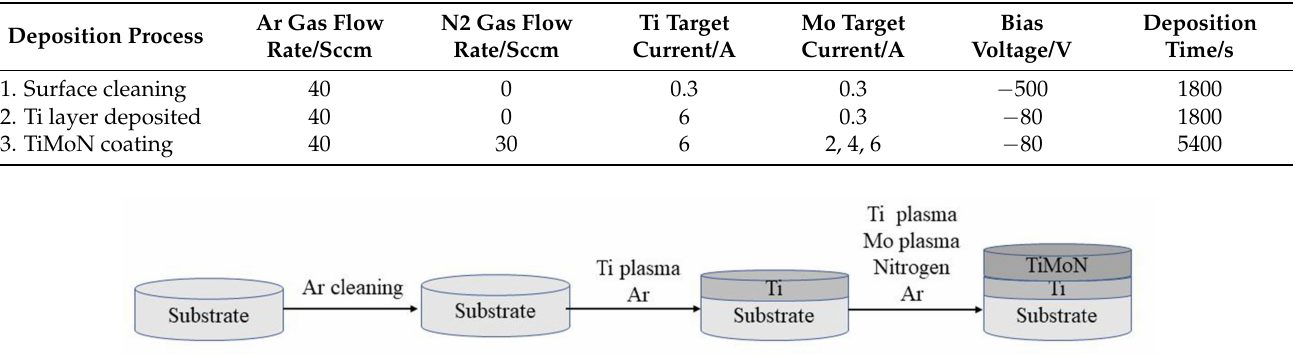
Figure 1. Deposition process of TiMoN